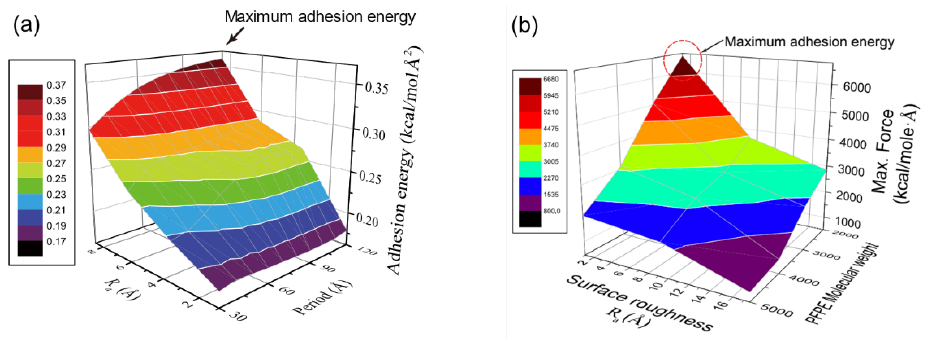
Figure 12. Variation of adhesion energy for ( a ) PI–glass and ( b ) SPFPE–glass interface (adapted with permission from References [30,31], Copyright 2019 and 2017 American Chemical Society). permission from References [30,31], Copyright 2019 and 2017 American Chemical